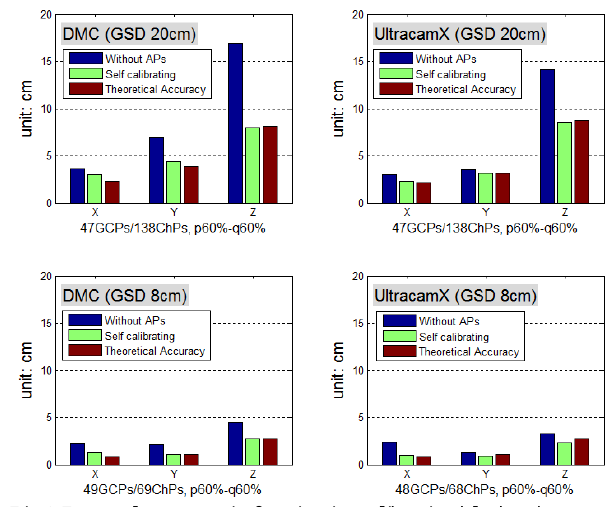
Fig.1 External accuracy in four in-situ calibration blocks, dense GCPs and p60%-q60% (‘without APs’ indicates without using Fourier APs only)